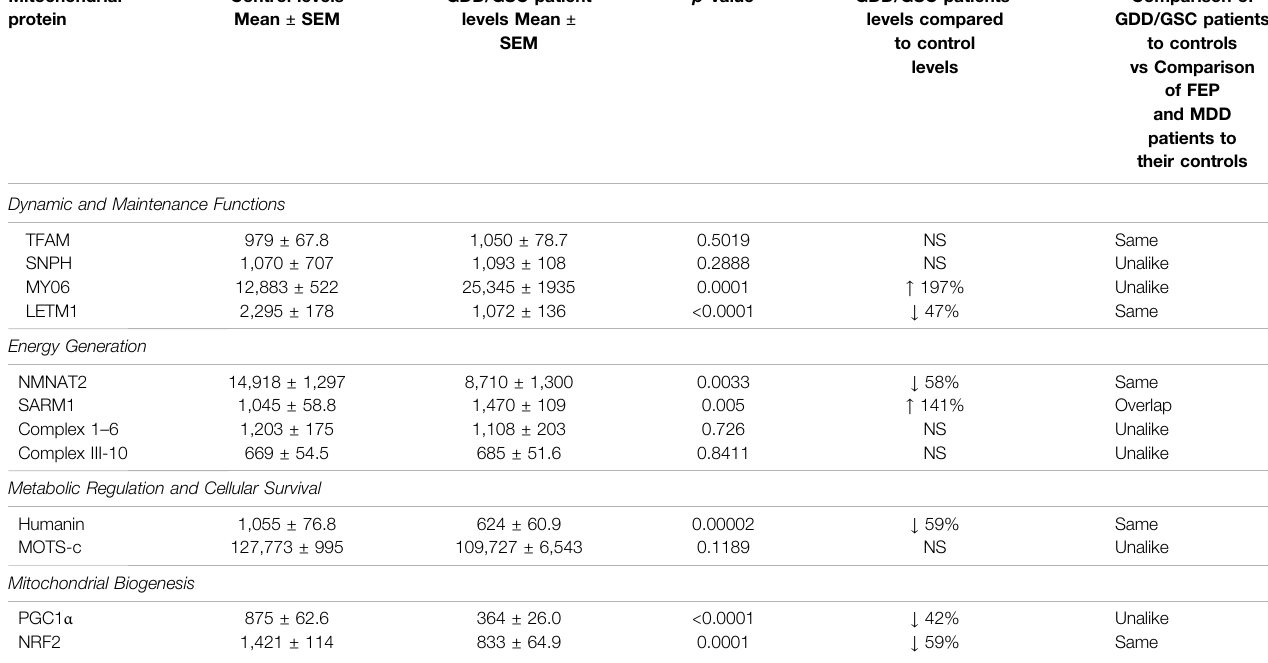
Fifth column: the mean percentage difference between GDD/GSC, patients ’ levels and control levels; NS, no statistically signi fi cant difference. Sixth column: Same (cid:1) the direction and approximate magnitude of GDD/GSC patient differences from controls are the same as those for FEP (First Episode Psychosis) and MDD (Major Depressive Disorder) patients vs their controls; Unalike (cid:1) distinct differences in comparisons to controls than were observed for FEP and MDD patients compared to their controls; Overlap (cid:1) similarity to differences from controls for only FEP or MDD patients, not both patient groups. Abbreviations : Complex I-6 (cid:1) subunit 6 of NADH-ubiquinone oxidoreductase; complex III-10, subunit 10 of cytochrome b-c1oxidase;NRF2 (cid:1) type2nuclearrespiratoryfactor;MY06 (cid:1) myosinVI;PGC-1 α (cid:1) PPAR c ,coactivator-1 α ;MOTS-c,mitochondrialopen-readingframeofthe12SrRNA-c;NMNAT2 (cid:1) nicotinamide mononucleotide adenylyl transferase 2; SNPH, syntaphilin; LETM1 (cid:1) leucine zipper EF-hand containing transmembrane 1 protein; SARM-1, Sterile Alpha and TIR, motif- containing protein 1; and TFAM, transcription factor A